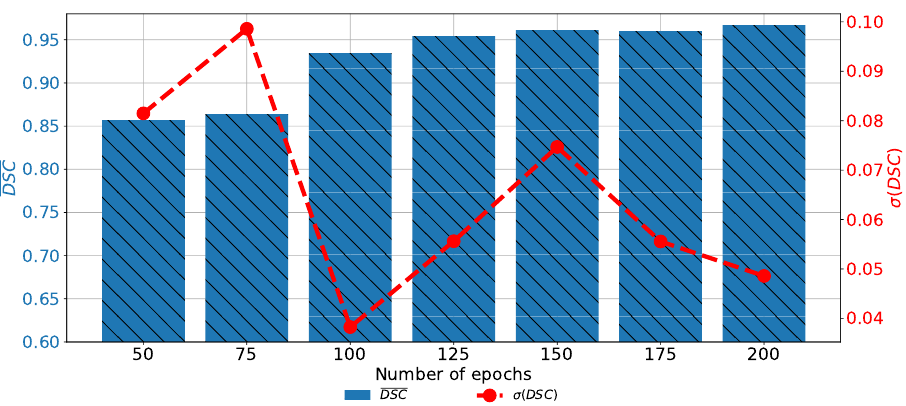
Figure 14. The change of DCS and σ ( DSC ) through a number of epochs achieved with pre-trained VGG-16 architecture as U-net backbone for the semantic segmentation of urinary bladder cancer masses from CT images in the sagittal plane.